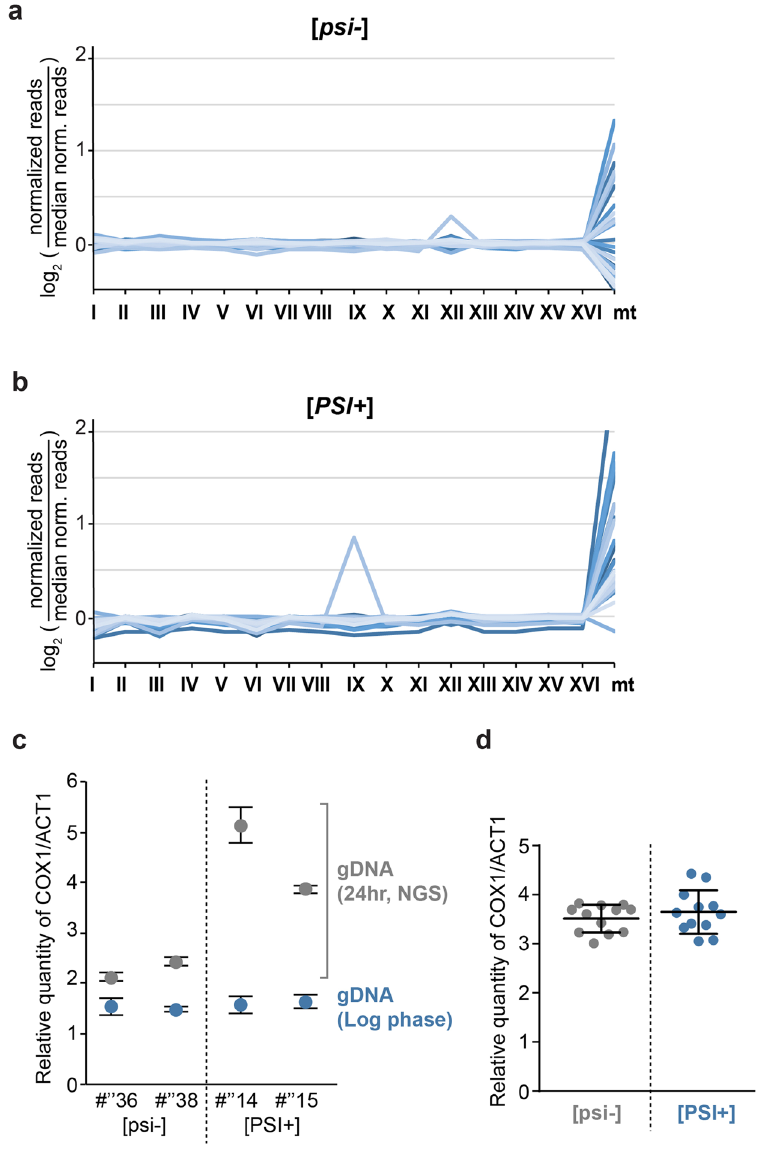
Figure 6. Survey of chromosome copy number by whole genome sequencing. ( a , b ) For sequencing reads matching each indicated chromosome, the log 2 ratios of the “normalized reads” ( i . e ., percent of reads matching a given chromosome in a given strain) divided by the “median normalized reads” ( i . e ., median of percentages of reads matching a given chromosome in all [ psi − ] strains) were reported for 30 [ psi − ] SILAC strains ( a ) and 30 [ PSI + ] SILAC strains ( b ) selected on YPD plates after Sup35NM overexpression. Each strain is represented by a line in a different blue colour. ( c ) mtDNA levels of the indicated strains were quantified by comparing relative mitochondrial COX1 vs. nuclear ACT1 genes using qPCR. The genomic DNA (gDNA) used for the NGS analysis was analyzed (grey), as well as gDNA obtained from the same strains that were kept in the logarithmic growth phase (blue). Standard deviations are from three technical replicates. #” designates strains that were generated for the whole genome analysis. ( d ) 12 [ psi − ] and [ PSI + ] strains previously used for NGS were grown for 24 hours in YPD with excess adenine (100 mg/mL) to stationary phase. mtDNA levels were then quantified by comparing relative mitochondrial COX1 vs. nuclear ACT1 genes using